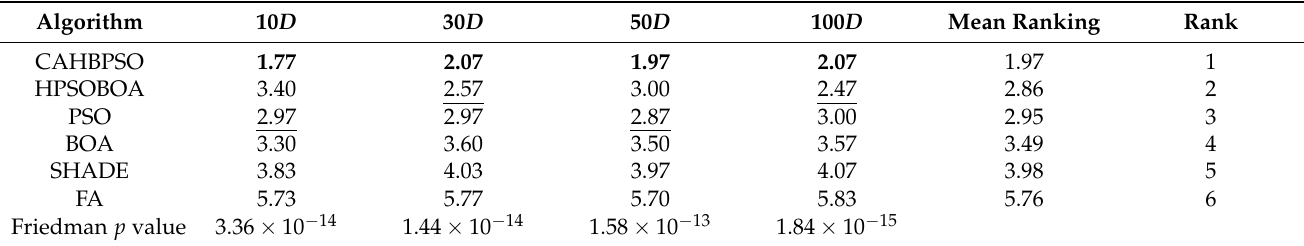
Table 3. The obtained average ranks using Friedman test for all investigated algorithms across all functions and dimensions using CEC2014, with α =